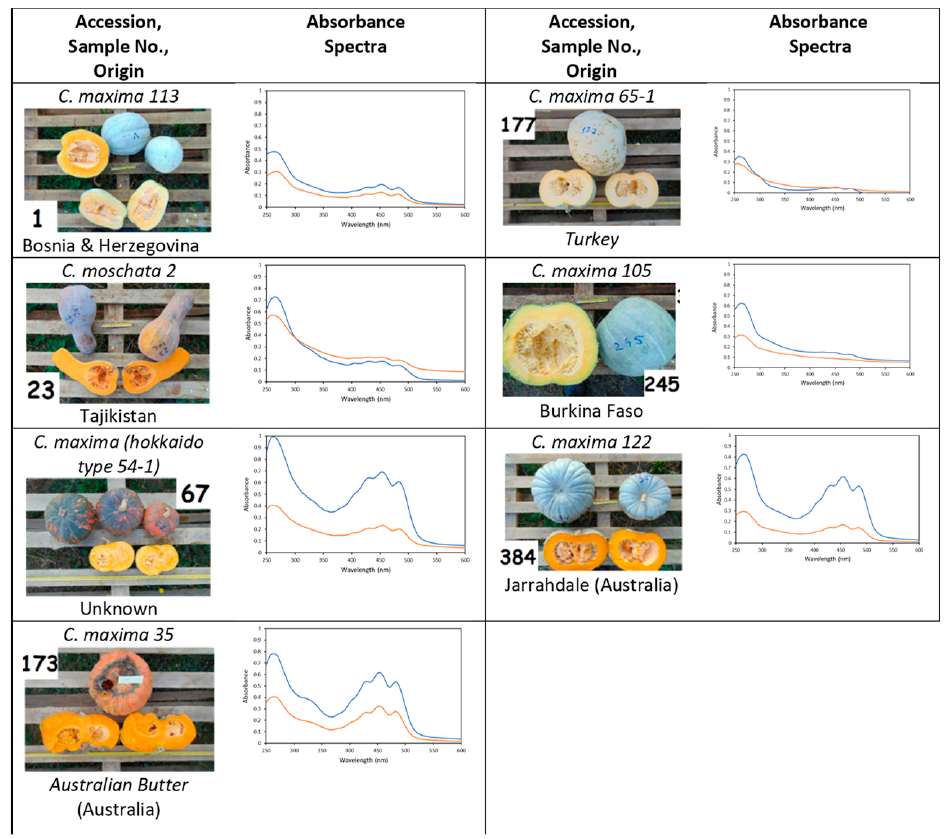
Figure 2. Pumpkins not originally from Serbia: images, sample number (in bold) associated with plot number in which each variety was grown, geographical origin (when known), and absorbance spectra (blue line = 1st extraction; orange line = 2nd extraction. See Section 2.3). The absorbance spectra cover the absorbance values ranging from 0 to 1 (increments of 0.1) and from 250 to 600 nm (increments of 50 nm). Pumpkin calibres are more clearly visualized in Figure S2 (Supplementary material), and weight, length, and diameter are reported in Table S3 (Supplementary material).